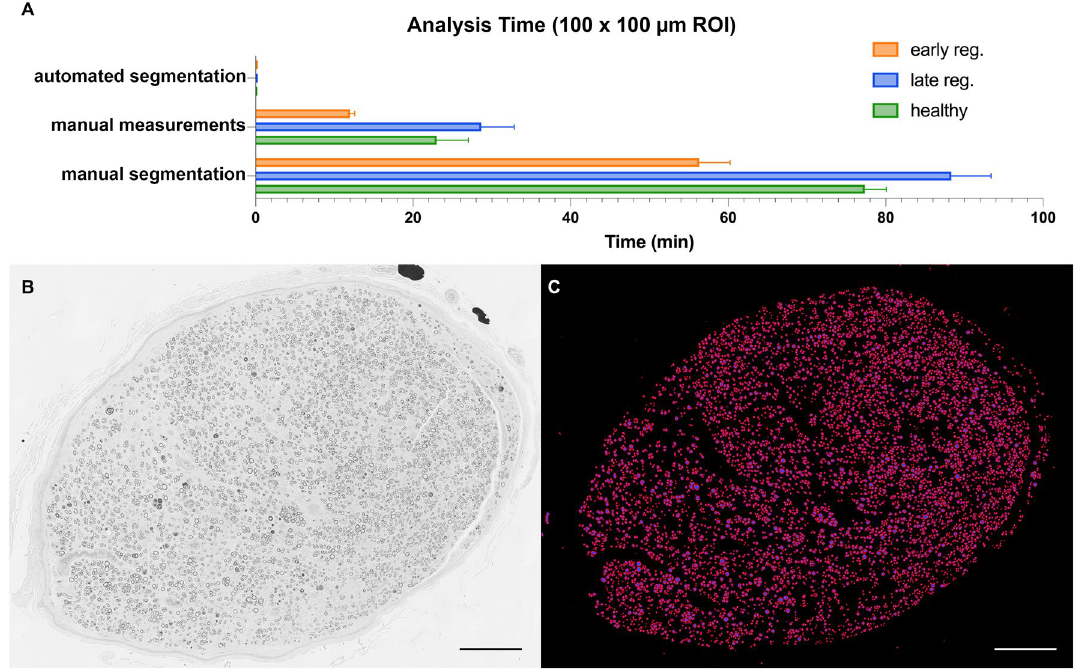
Figure 5. Analysis time. ( A ) Mean (± SEM) analysis times for a 100 × 100 µm region of interest in healthy nerves (green), early regeneration stages (orange) and late regeneration stages (blue) using automated segmentation with AxonDeepSeg, manual measurements with a straight-line tool in ImageJ or manual segmentations in GIMP. ( B ) To demonstrate the capabilities of AxonDeepSeg, we segmented an entire nerve cross-section of a rat median nerve 50 days after epineural nerve repair and 5 mm distal to the nerve repair site. Osmium tetroxide postfixed, epoxy embedded, 1 µm thickness. ( C ) The result of the segmentation included a total of 5894 myelinated nerve fibers after a computation time of 6 min and 11 s. The scale bars in B and C represents 100 µm. (Own illustration created with